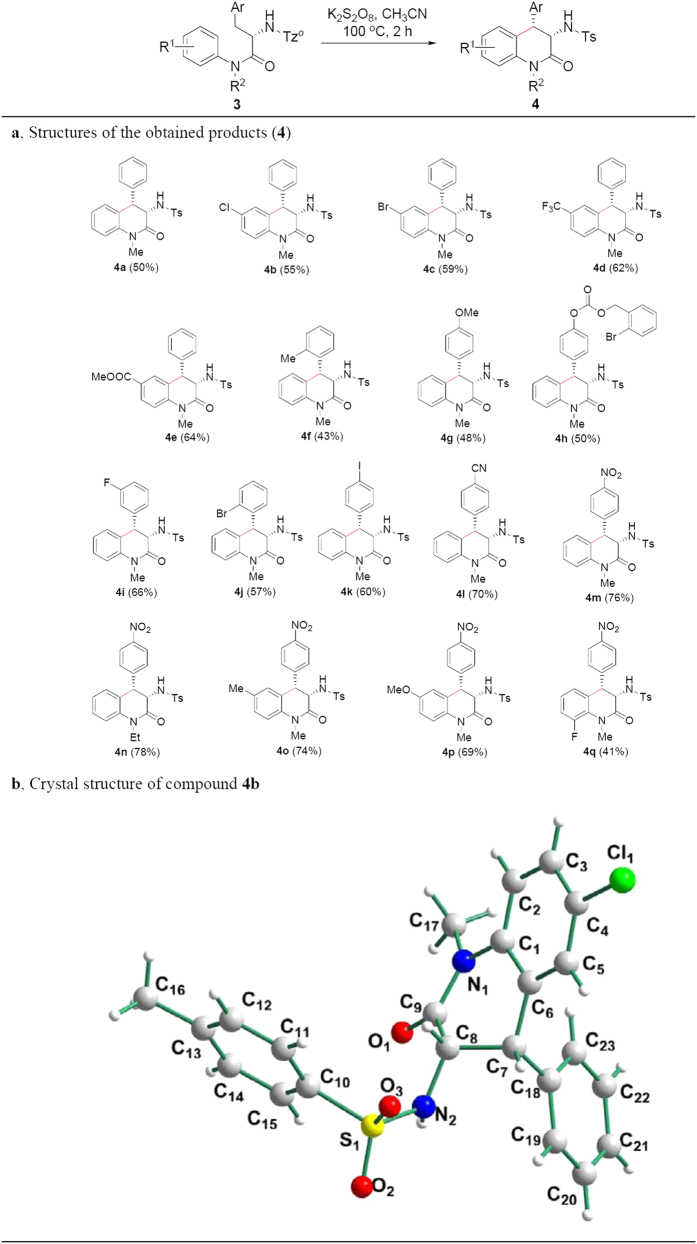
Substrate scope for couplings of benzylic C-H and aromatic C-H bonds.(a) Structures of the obtained products (4). (b) Crystal structure of compounds 4b. Reaction condition: under nitrogen atmosphere, 3 (0.1 mmol), K2S2O8 (0.2 mmol), CH3CN (2.0 mL), reaction temperature (100 °C), reaction time (2 h) in a sealed Schlenk tube. *Isolated yield. Structures of diastereomers were identified by 1H NMR analysis and X-ray diffraction analysis.